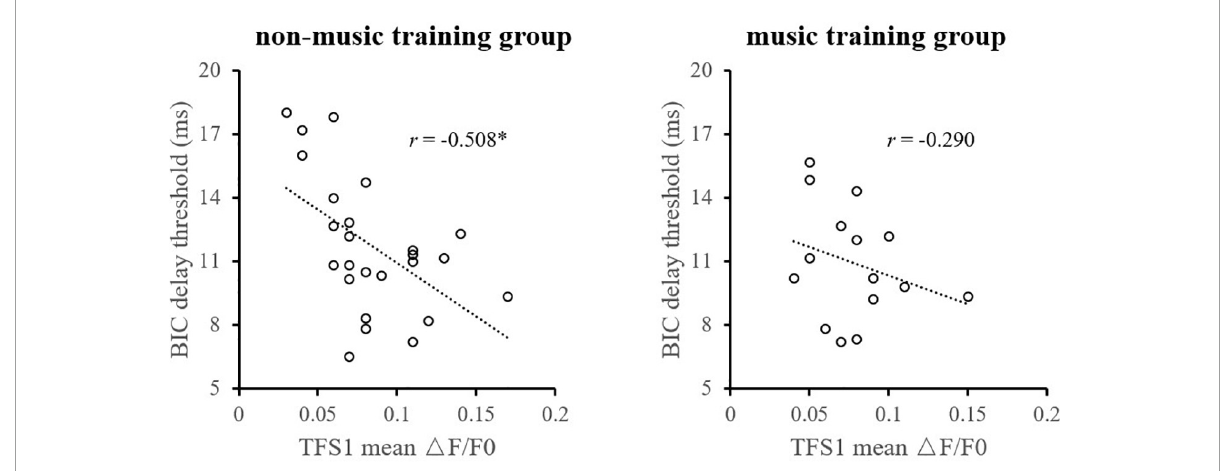
FIGURE7 Illustration of the correlation analysis of the BIC delay threshold and the TFS1 and TFS-AF test. ∗ Significant effect after Bonferroni’s correction, p <